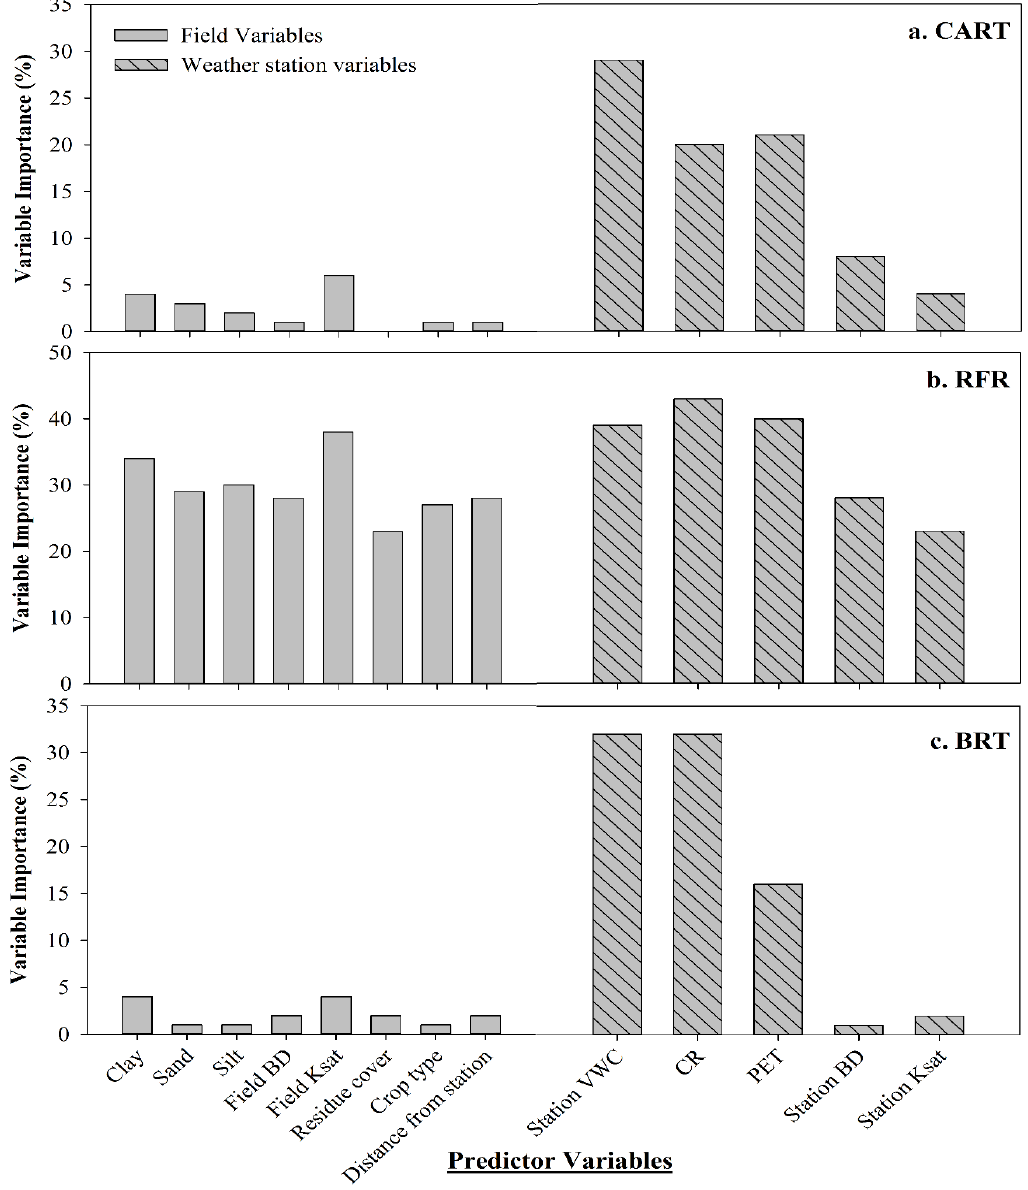
Figure 4. Variable importance for 3 tree-based model types: ( a ). classification and regression trees (CART), calculated as the relative influence (%); ( b ). random forest regression (RFR), calculated as the increase in mean squared error (MSE) (%); and ( c ). boosted regression trees (BRT), calculated as the relative influence (%). Out of 13 predictor variables, the first 8 represent field, and remaining 5 represent station variables. As the calculation of variable importance differs among CART, RFR and BRT, only the ranking of the variables can be compared, not the absolute values.